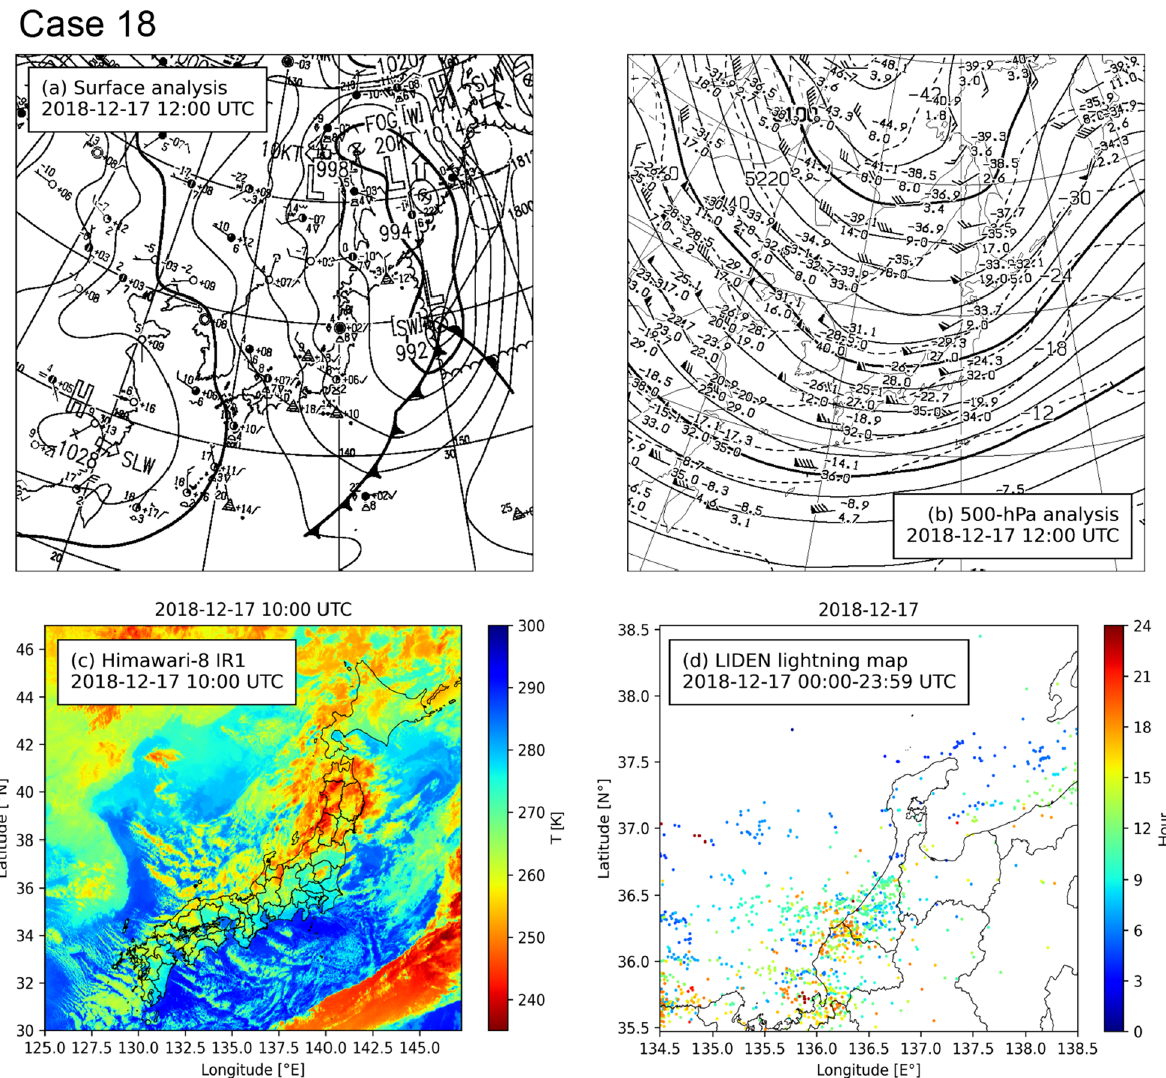
Fig. 3 Meteorological charts of the glow-detection Case 18 in the same format as Fig.